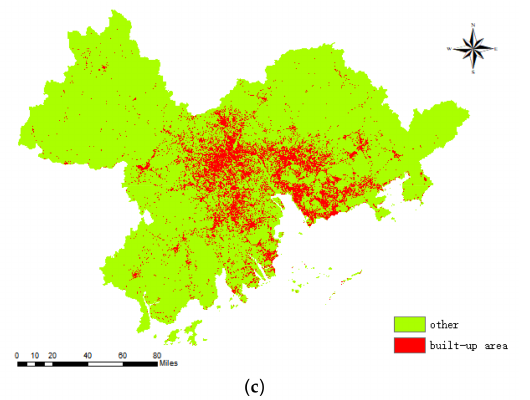
Figure 5. Urban built-up area in the PRD in 2013, 2016, and 2019. ( a ) 2013, ( b ) 2016, ( c ) 2019. Data source: Landsat 8